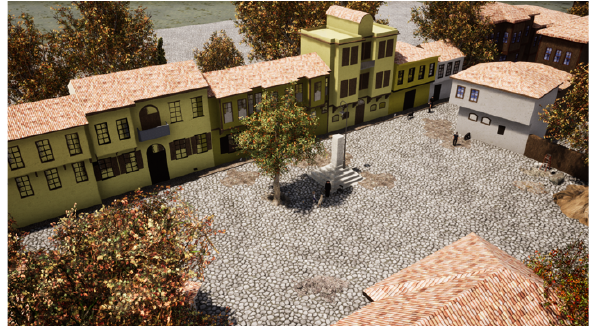
Figure 4. Virtual reconstruction of Smyrna Theatre using Image Based Modeling – Izmir